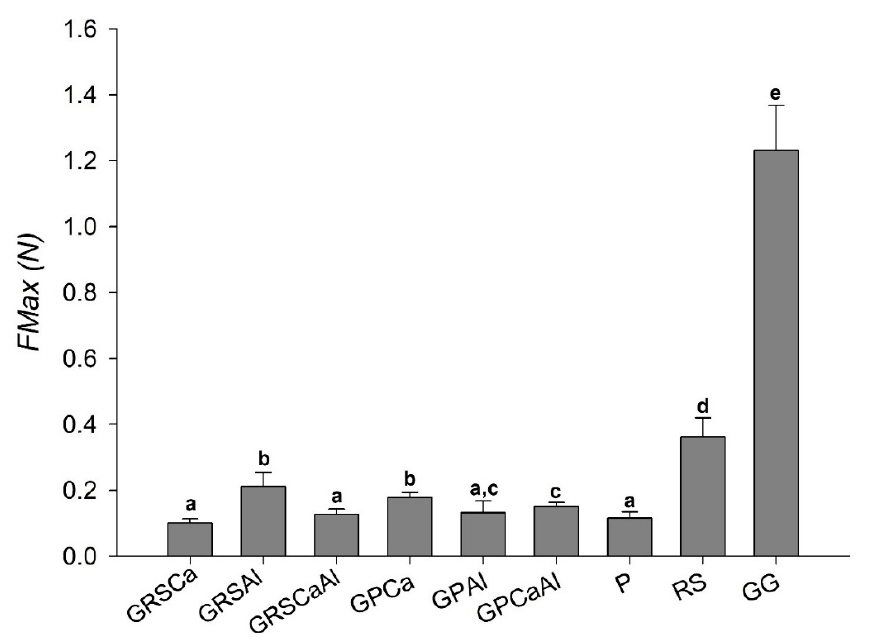
Figure 5. Maximum mucoadhesion force ( FMax ) of microparticles: pectin (P), retrograded starch (RS), and gellan gum (GG).